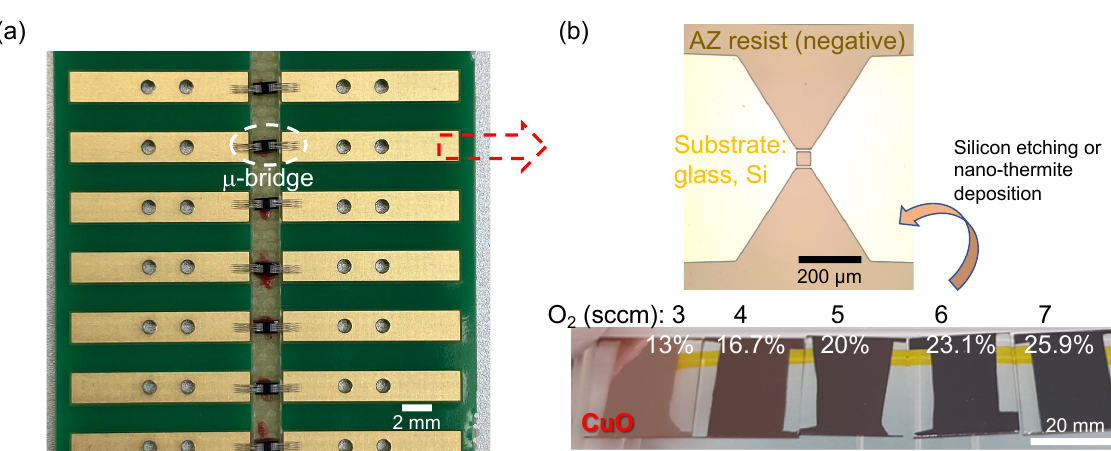
Figure 1. ( a ) µ-bridge (lithographically defined silicon or nano-thermite layers) glued and wire-bonded in a PCB mount with accessible contact pads at either end. A capacitor is discharged across the contacts with the voltage measured in parallel using a differential probe and current measured with a clamp meter. ( b ) Top: optical micrograph of one of the designs of the µ-bridge defined in the AZ1505 resist after exposure and development; the typical width of the bridge connection was ∼ 50 µm. Etching of the silicon was performed using such resist patterns on the substrate (glass or Si) as was the deposition of nano-thermites. Bottom: CuO films deposited with varying proportions of O 2 in the Ar carrier gas during plasma